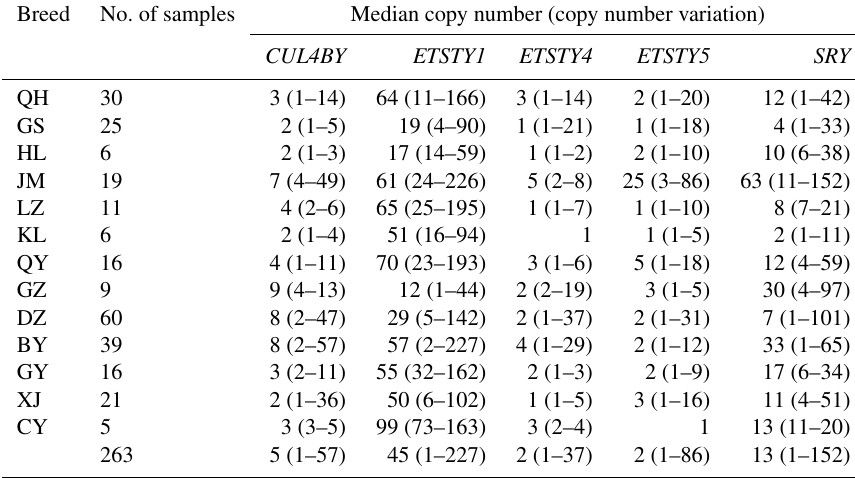
Table 4. Copy number variations of five Y chromosome genes in donkeys. Breed No. of samples Median copy number (copy number